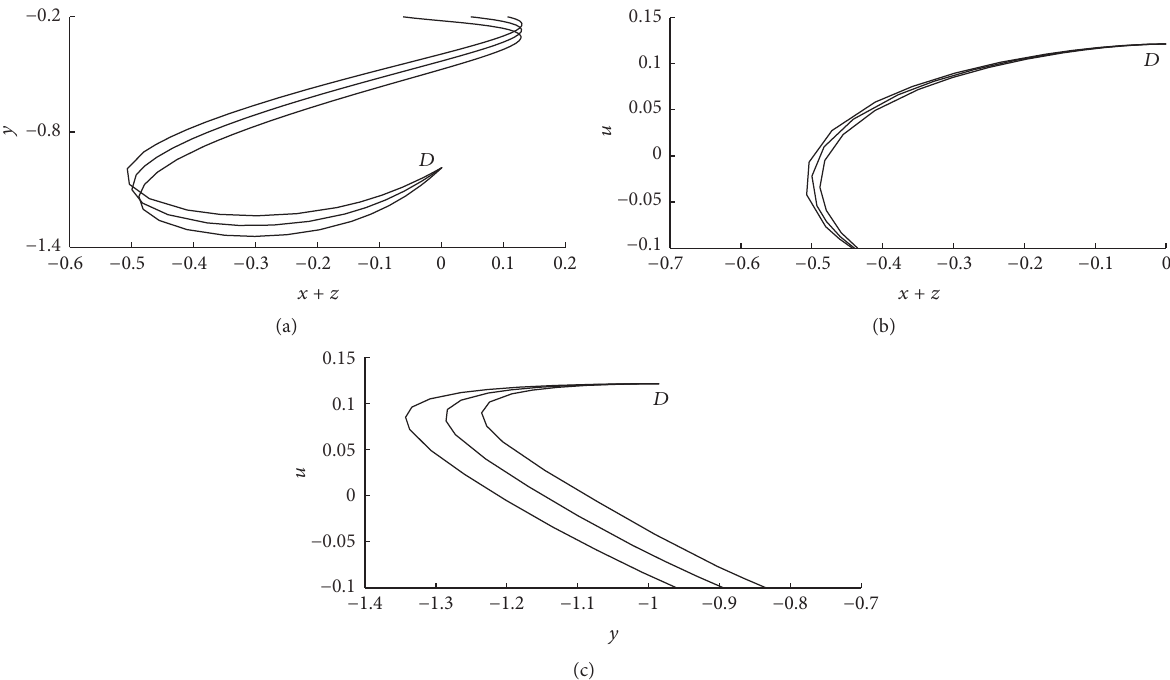
Figure4:Two-dimensionalprojectionsofthephase-spacetrajectoriesforstabilityconditions 𝜉 = 2 , 𝜆 = 1 andforpresentdayvalues 𝛽 = 14.5 , = 0.3 . All plots begin from the critical point 𝐷 being a stable Ω 𝑚